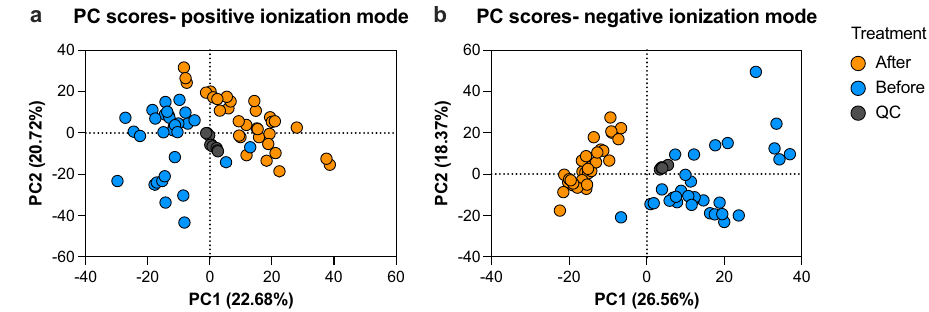
Figure 2. PCA score plots of pig saliva metabolome. A Principal Component Analysis (PCA) plot of the metabolome data that characterizes pig saliva before (Blue) and after (Orange) acute stress. Each dot represents a sample and the colour represents the type of sample. Repeatability (Grey) is demonstrated by pooled samples, injected along the analyses as quality controls. ( a ) A PCA score plot of metabolite features from data acquisition in positive ionization mode. ( b ) A PCA score plot of metabolite features from data acquisition in negative ionization mode. Graphs were created by GraphPad Prism (version 9.4.).